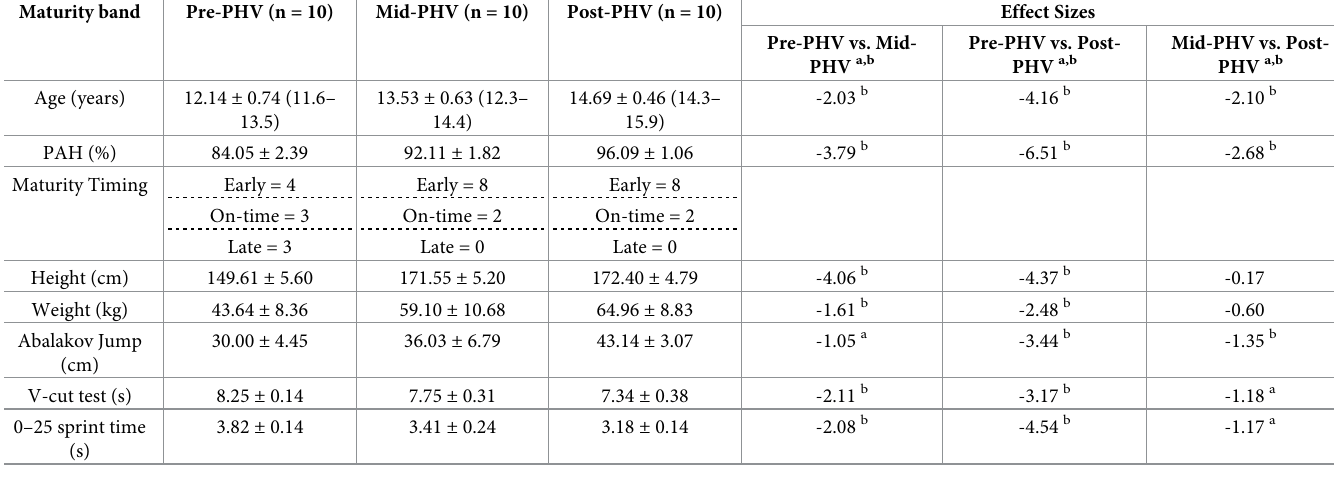
Table 1. Participant characteristics of maturation groups.